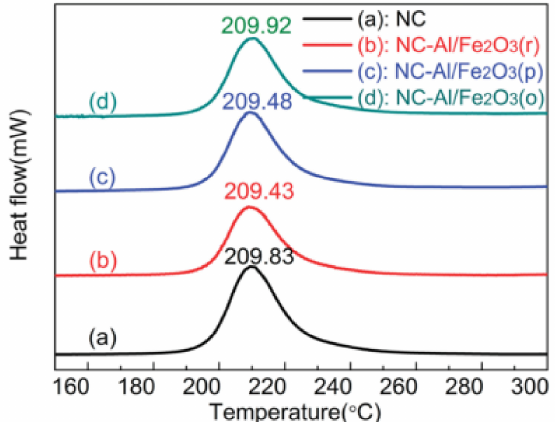
Figure 36. SEM images of Al/Fe 2 O 3 . ( a ) Al/Fe 2 O 3 (r); ( b ) Al/Fe 2 O 3 (p) and ( c ) Al/Fe 2 O 3 (o). ( a – c ) Reproduced with the permission of ref. [154]. Copyright 2017, RSC Advances.